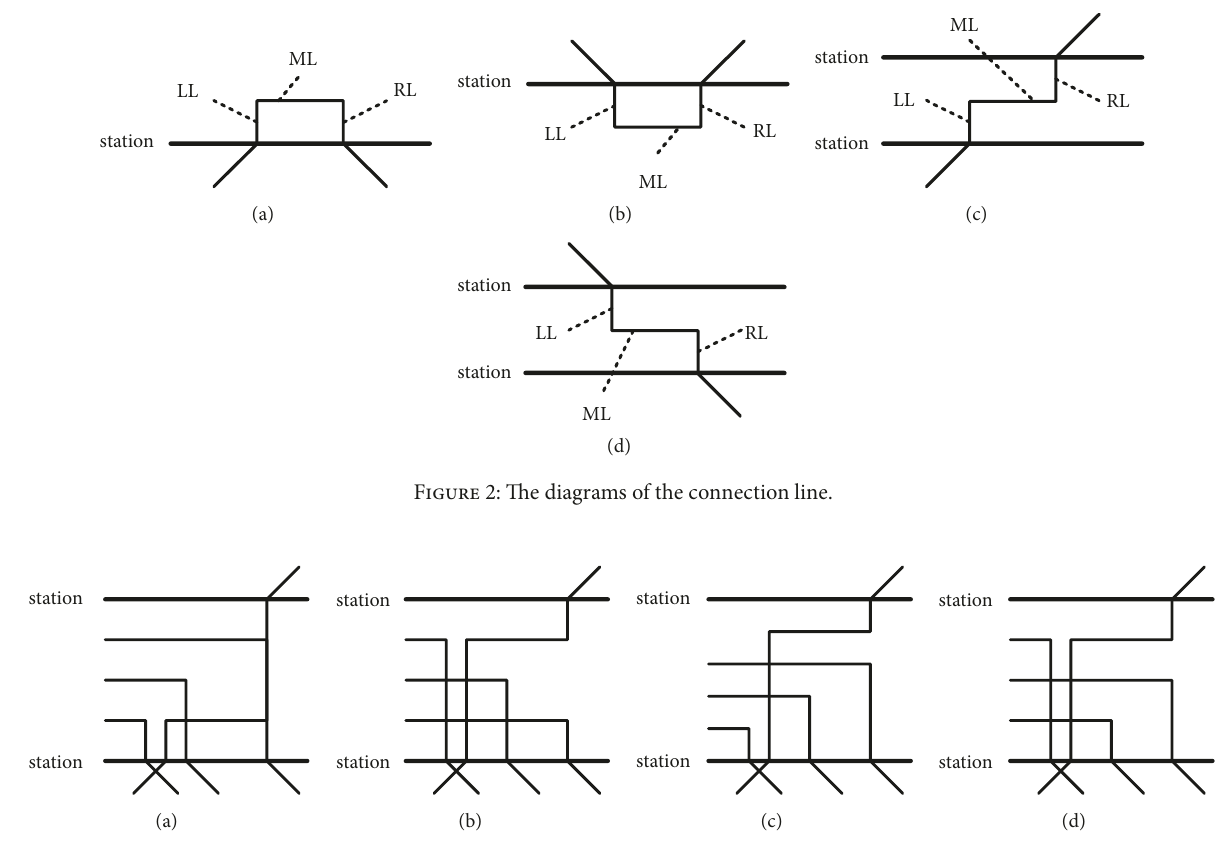
Figure 3: Commonly seen problems and solutions in traditional locomotive working diagrams editing